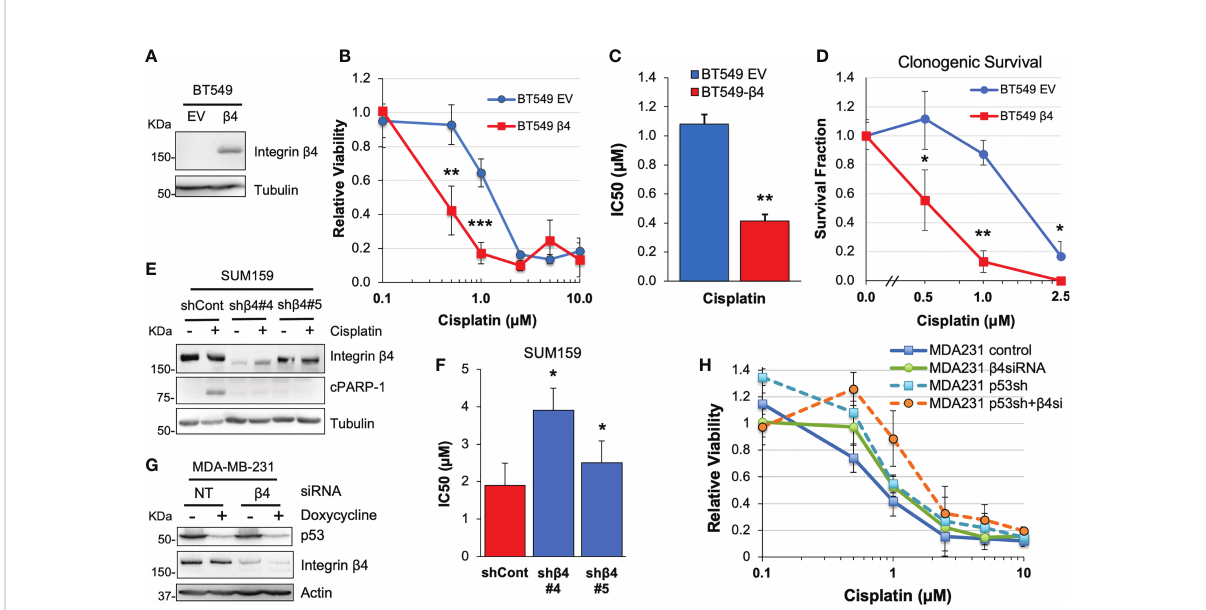
FIGURE 1 Integrin a 6 b 4 signaling sensitizes cells to cisplatin treatment. BT549 cells expressing EV or wildtype integrin b 4 (A) were treated with varying doses of cisplatin for 6 days. Cell viability was assessed by MTT assays (B) and IC50 was calculated (C) or relative clonogenic survival determined (D) . (E, F) SUM159 cells with integrin b 4 shRNA knockdown (sh b 4) or control shRNA (shCont) (E) were treated with different doses of cisplatin and IC50 calculated from cell viability assays (F) . (G, H) Mutant p53 was knocked down in a doxycycline-inducible manner in MDA-MB-231 cells and/or integrin b 4 was knocked down by siRNA. Cells were then plated on laminin-1-coated plates, treated with various doses of cisplatin for 6 days. Ef fi ciency of target knockdown was monitored by immunoblotting (G) and cell viability was assessed by MTT (H) . *p < 0.05, **p < 0.001, ***p <